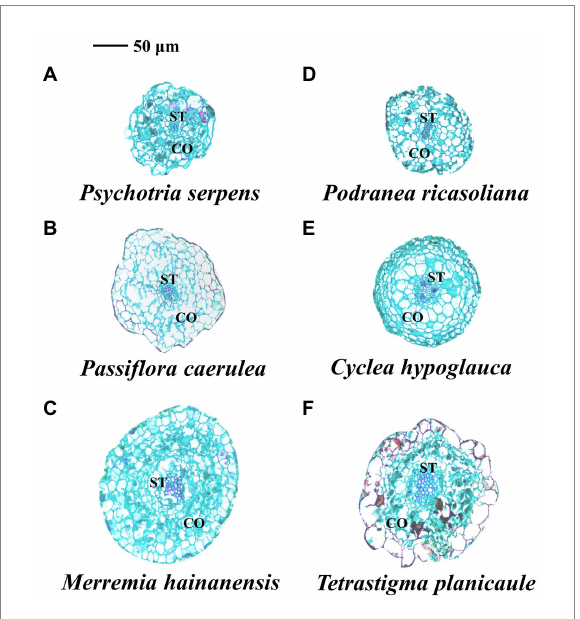
FIGURE 5 Anatomical structure of root tips in three vine (A–C) (herbaceous climbing plants) and three liana (D–F) (woody climbing plants) species in tropical forest. CO: cortex; ST: